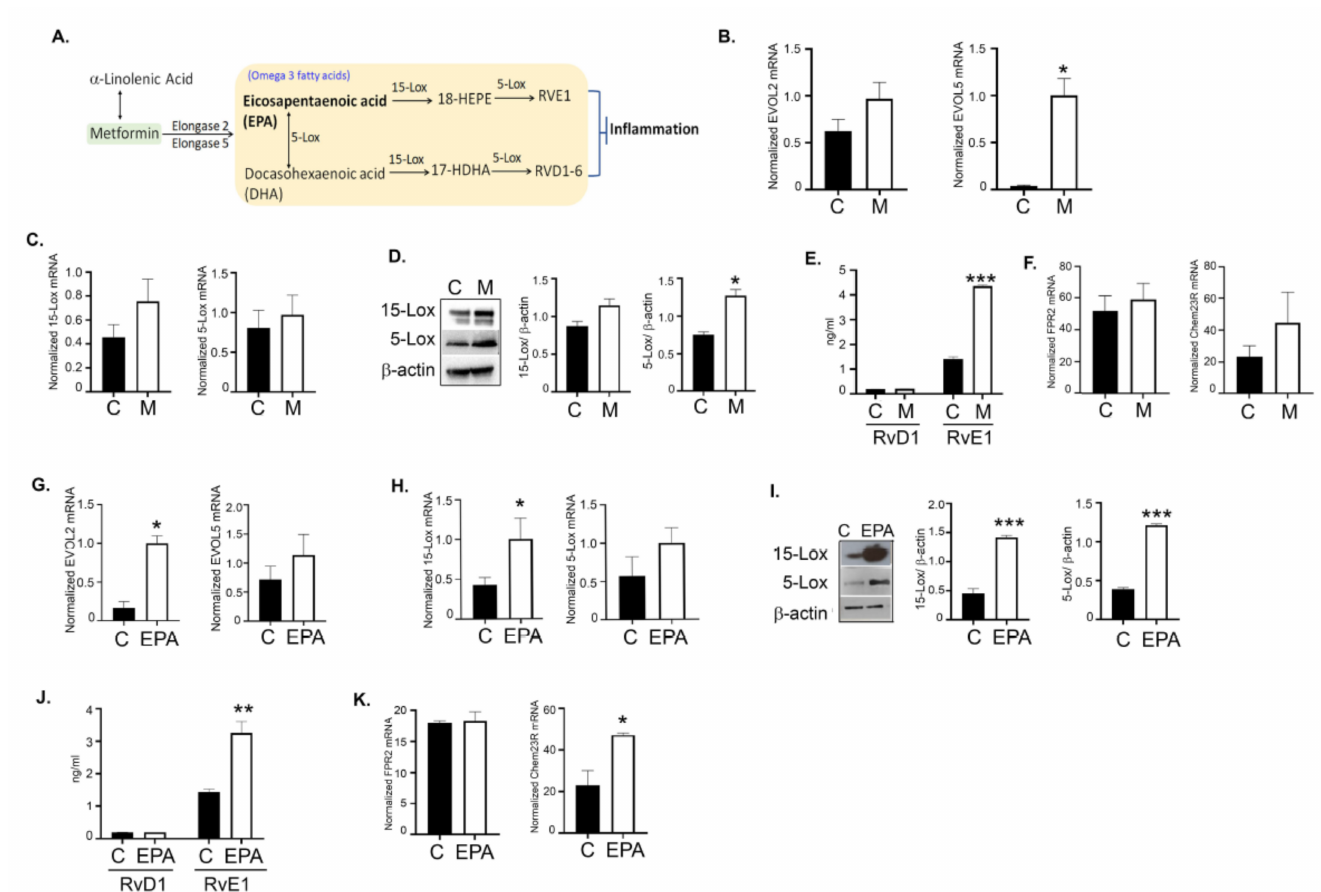
Figure 10. Metformin and EPA promote formation of specialized pro-resolving mediators. ( A ) A simplified schematic of the source of SPMs from EPA and DHA. ( B ) mRNA expression of ELOVL2 and ELOVL 5 in pooled CaOV3 tumors ( n = 3) treated with metformin or vehicle control. ( C ) mRNA expression and ( D ) protein expression of 5-LOX and 15-LOX in pooled CaOV3 tumors ( n = 3)